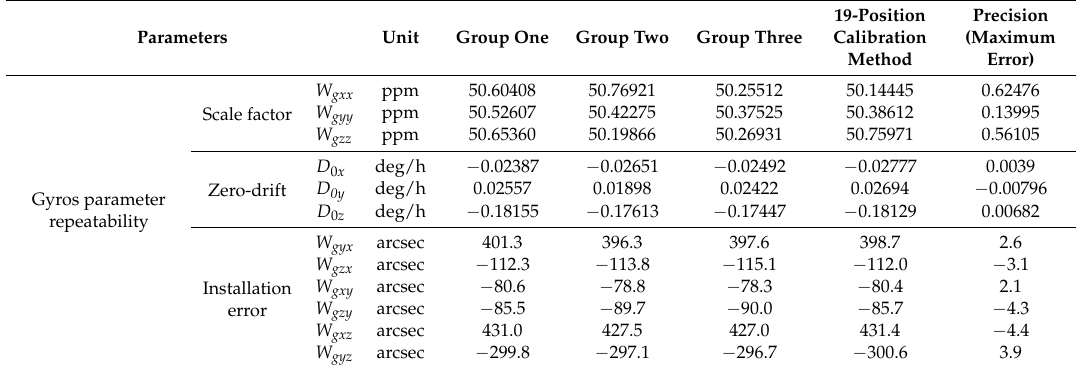
Table 3. Experiment data.